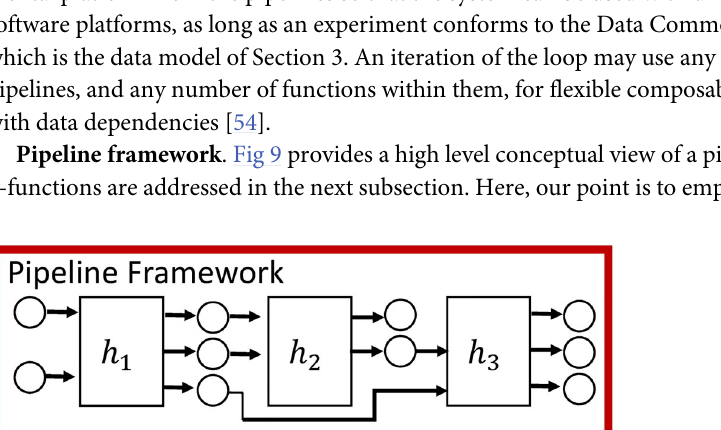
are threshold functions for v i ; s t ; s t ; s t ; s t ; s t Þ . The system reaches a fixed point at time t = 3, as evidenced by no 1 2 3 4 5 6